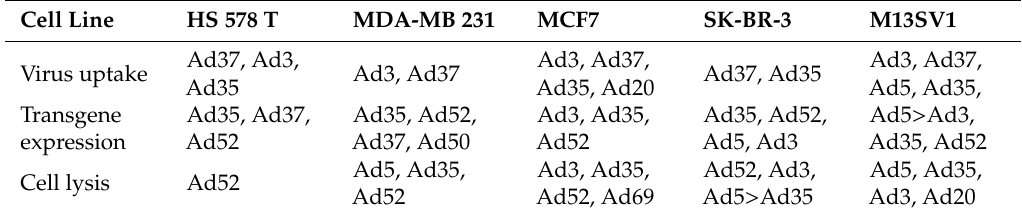
Table 2. Summary of adenovirus infection in breast cancer-related cell